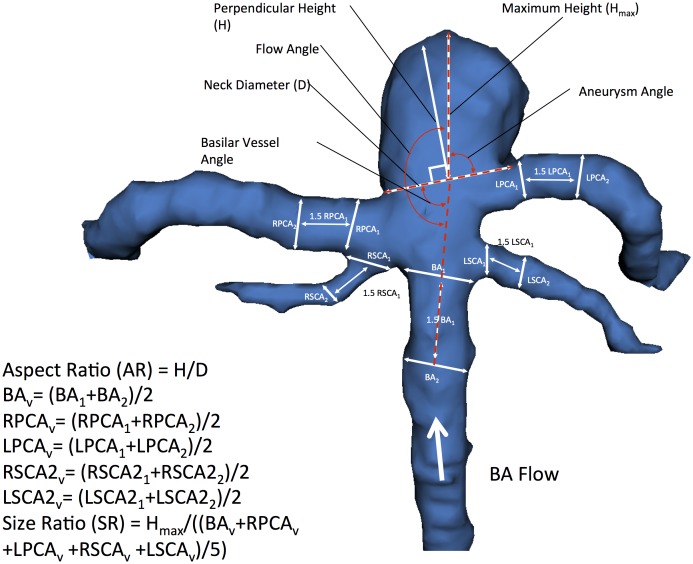
3D model of BTA aneurysm depicting morphological variables previously studied in the literature.The aspect ratio (AR) is obtained by dividing the perpendicular height by the neck diameter. Size ratio (SR) is calculated by dividing the maximum height (Hmax) by the average composite diameter of the all vessels (BAv, RPCAv, LPCAv, RSCAv, LSCAv) involved with the aneurysm. Composite diameters are obtained by averaging the initial diameter of the vessel (BA1, RPCA1, LPCA1, RSCA1, LSCA1) at the vessel branching point by the aneurysm neck with the diameter of the vessel 1.5 away from the initial diameter (BA2, RPCA2, LPCA2, RSCA2, LSCA2). Aneurysm angle is defined as the angle between the vectors formed by the maximum height of the aneurysm with the aneurysm neck. The vessel angle is defined as the angle between the vector of flow and the neck of the aneurysm. The flow angle is defined as the angle between the vector of flow and the vector formed by the maximum height of the aneurysm.